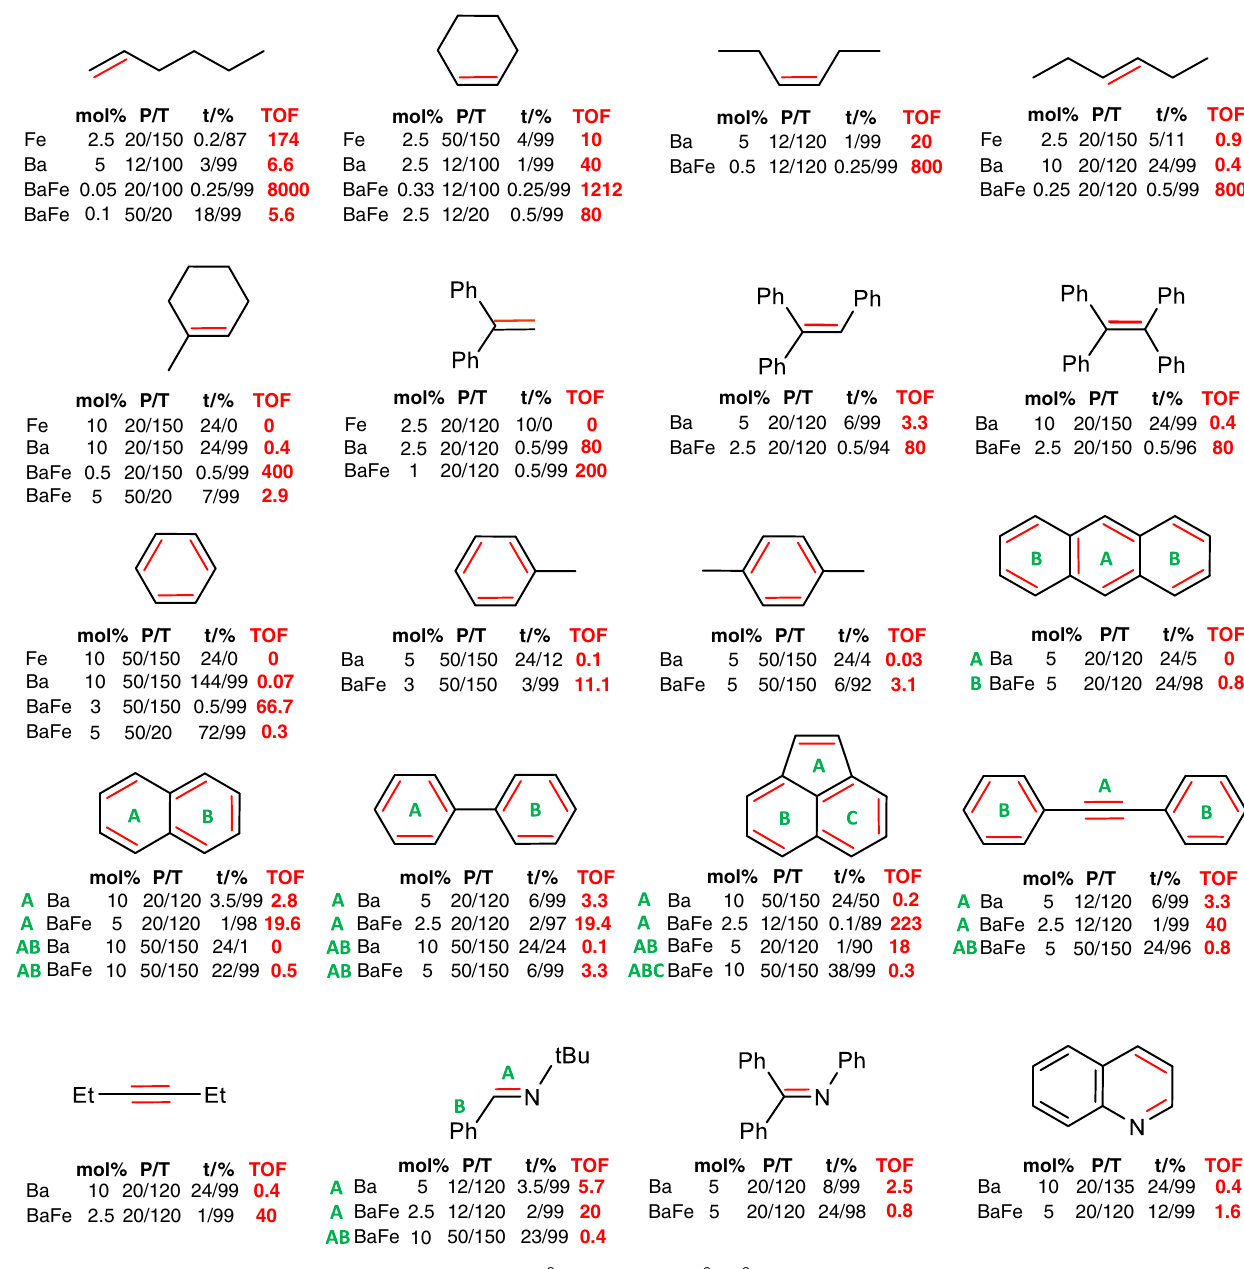
Fig. 3 Catalytic hydrogenation. Comparison of the activities for Ba 0 and the mixed Ba 0 /Fe 0 catalysts (the mixture was ground before use). P = H 2 starting pressure in bar (reactors were pressurized with H 2 and shut off from the H 2 source), T = temperature in °C, and t = time in hours which in most cases has been optimized for full conversion (99%). For comparison, TOF values (turn-over-frequency in h − 1 ) are given. The controversial use of TOF values is discussed in the Supplementary